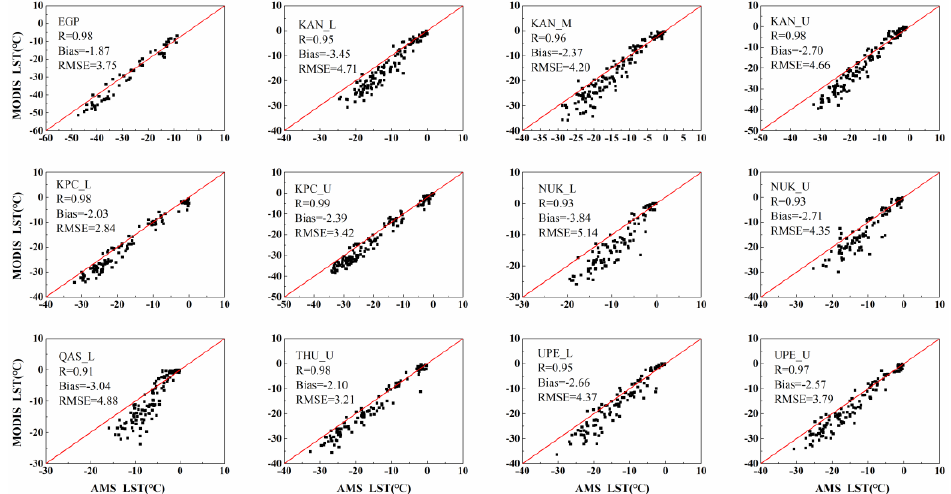
Figure 2. MODIS and Observed monthly LST, Observed LST is from AMS. the red diagonal represents the 1:1 line. * and ** Indicates a confidence level of 0.05 and 0.01.